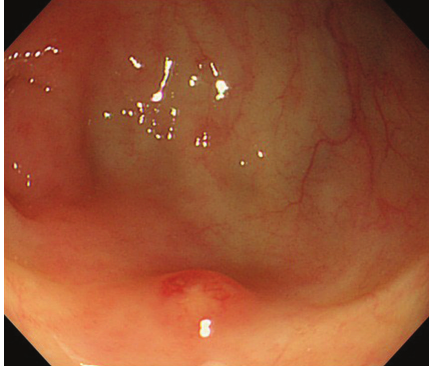
Figure 3: A tiny erosive nodule near the appendiceal orifice.